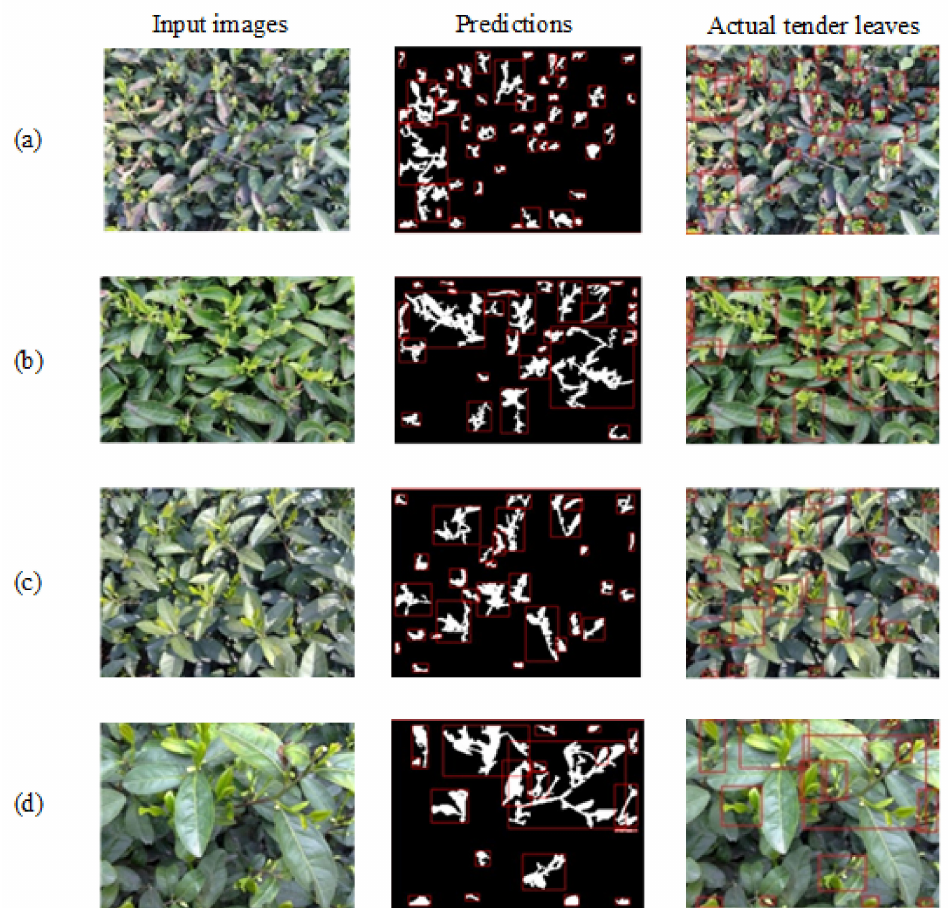
Figure 9. The model-generated bounding box predictions and actual tender leaf bounding box using RGB format. ( a , b ) The prediction of Longjing tea tree under strong and weak light conditions. ( c , d ) The prediction of Yuhua tea tree under strong and weak light